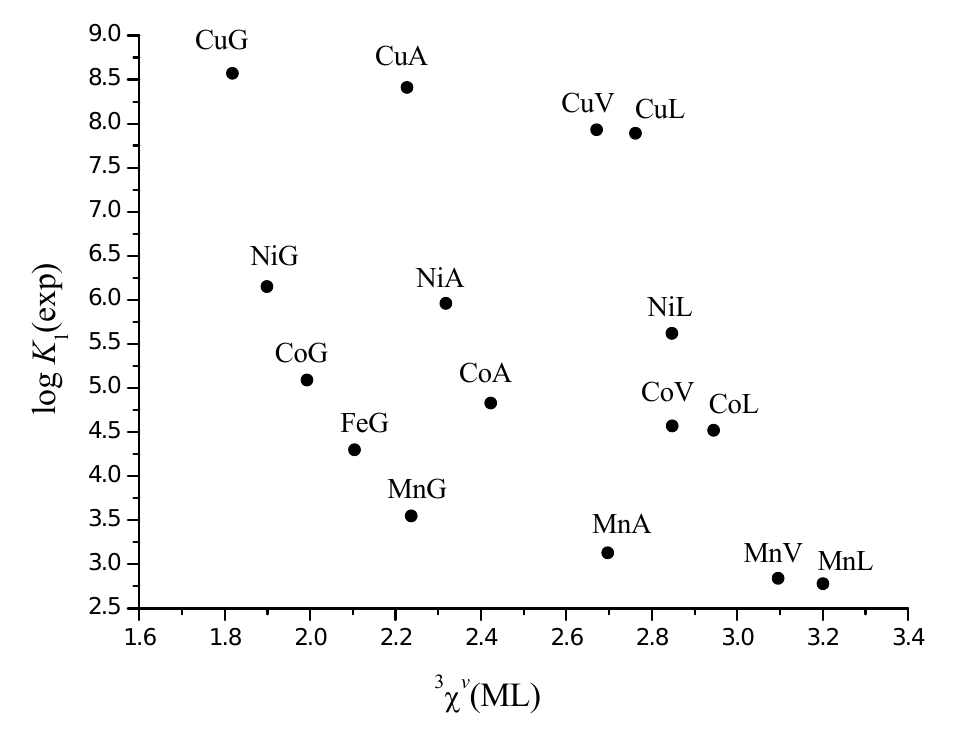
Figure 2. Experimental values of log K vs. connectivity 3 χ v index for Mn 2+ , Fe 2+ , Co 2+ , 1 Ni 2+ , and Cu 2+ complexes with glycine (G), alanine (A), valine (V) and leucine (L).